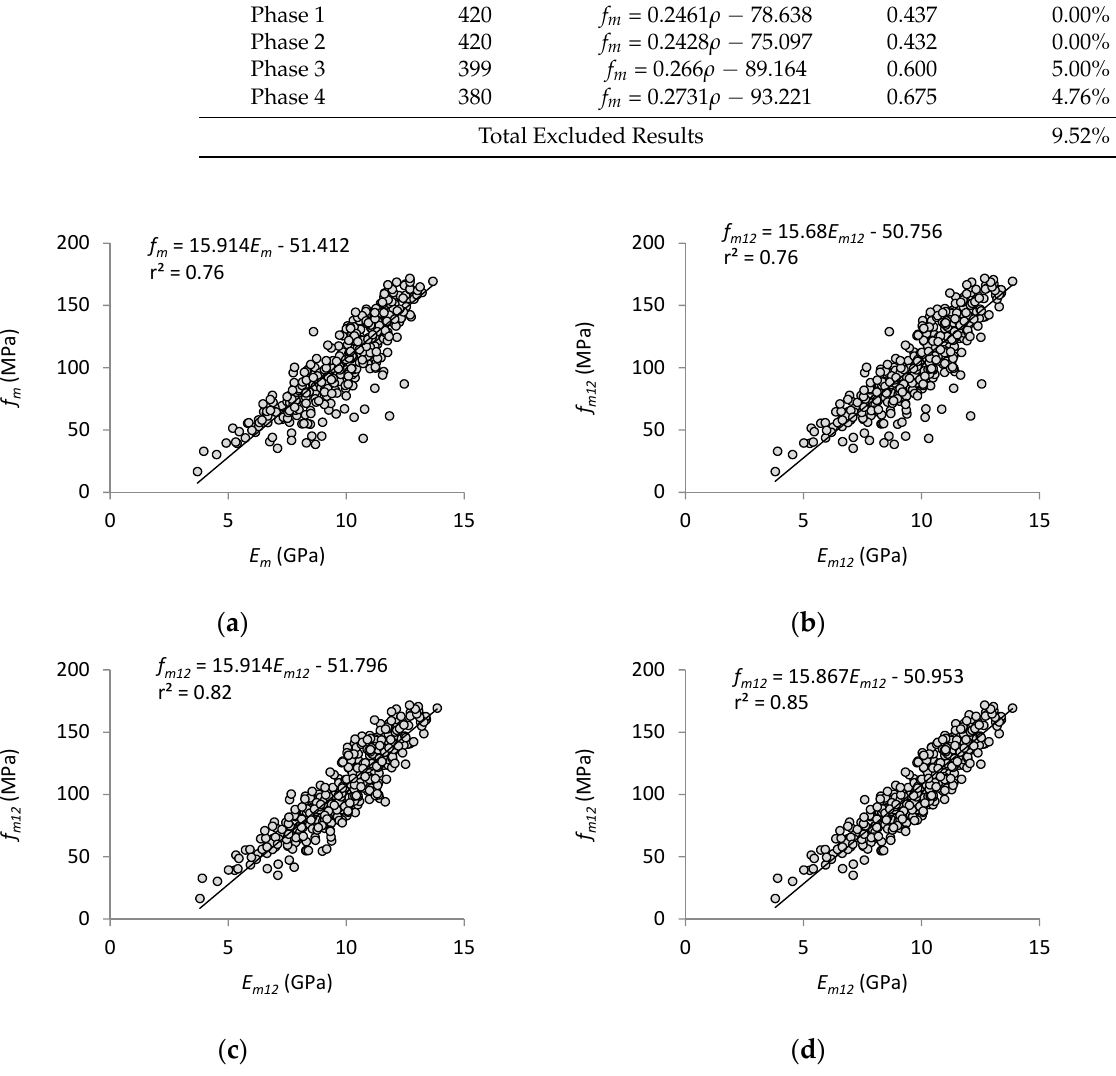
Figure 5. Correlation between modulus of elasticity ( E m ) and bending strength ( f m ). ( a ) With the moisture content at the time of the tests (Phase 1); ( b ) After the correction for a 12% of moisture content (Phase 2); ( c ) After excluding the outliers (Phase 3); ( d ) After excluding 5% of the values farthest from the linear regression expression. Table 6. Correlation between modulus of elasticity ( E m ) and strength ( f m ) in bending.